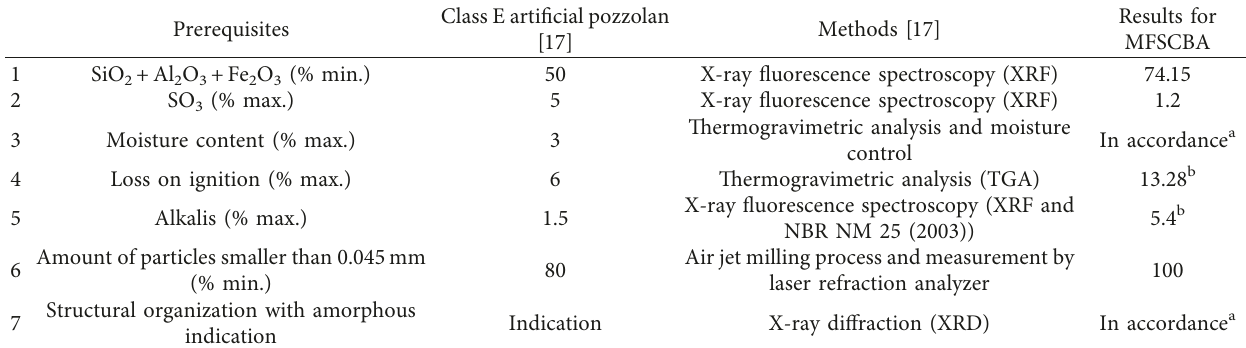
Table 1: Prerequisites, methods, and results of MFSCBA characterization.